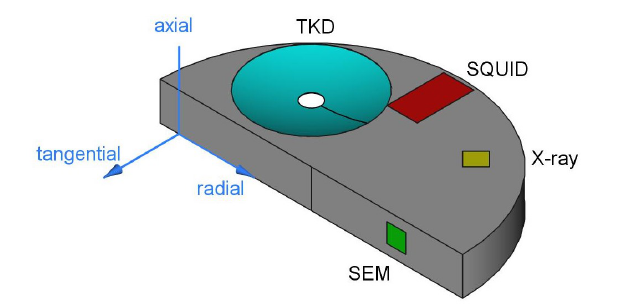
Figure 1. Schematic representation of half of an high-pressure torsion (HPT) sample. Regions for the described measurements are highlighted. Scanning Electron Microscopy (SEM) images are taken in a tangential direction of the sample at r ≥ 2 mm, Transmission Kikuchi Diffraction (TKD) investigations are carried out in the samples axial direction. X-ray diffraction (XRD) measurements are carried out in transmission mode (r ≥ 2 mm; beam parallel to axial direction). Samples for SQUID-magnetometric measurements are cut out at r ≥ 2 mm.